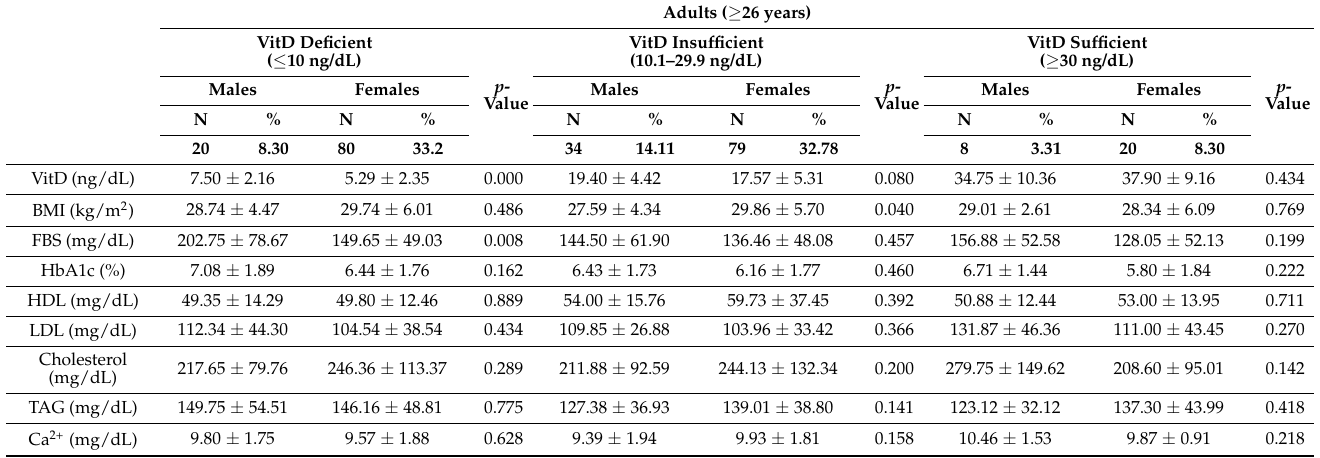
Table 3. VitD status and other health indicators in Libyan adults ( ≥ 26 years) according to VitD cut-off groups and